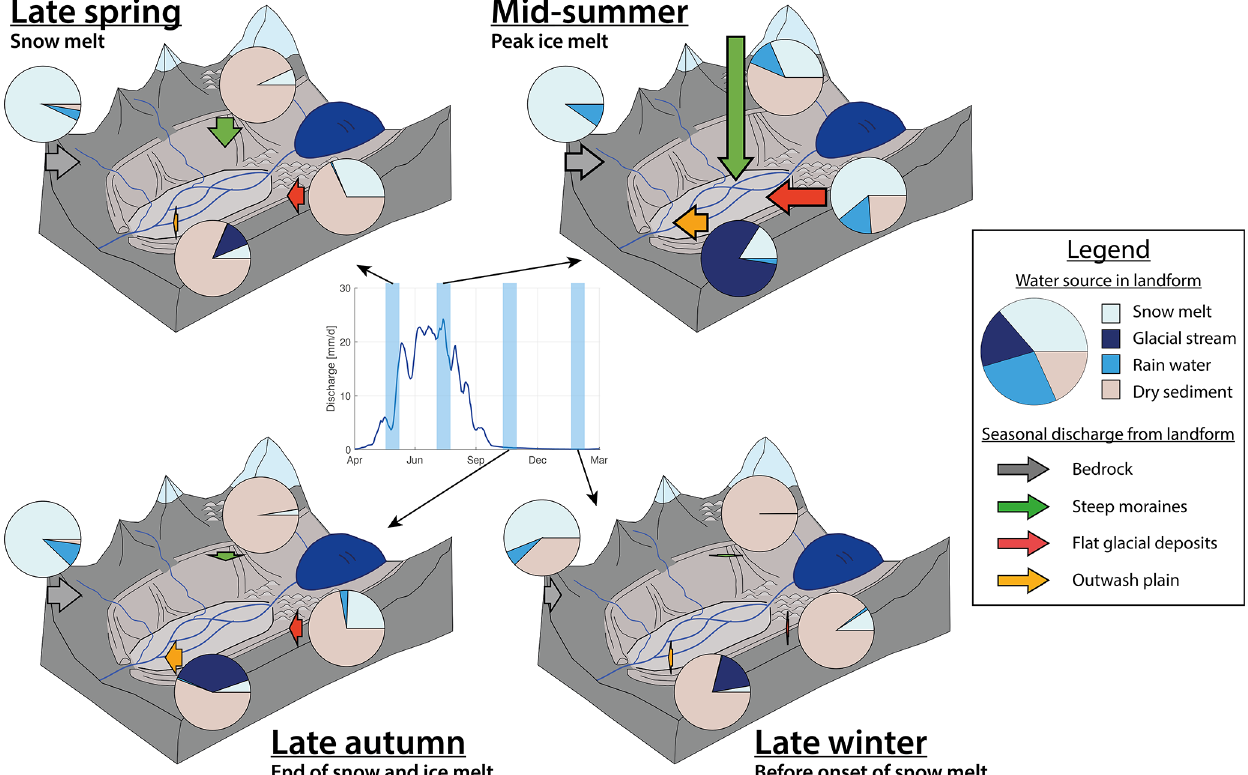
Figure 13. Perceptual model of groundwater dynamics in the Otemma catchment during four key hydrological periods. The central hydro- graph represents the mean daily catchment-scale river discharge for the year 2015. The pie charts represent the seasonal partitioning of the three water sources (rainwater, snowmelt, glacial stream) calculated based on recharge and outflow (Sect. 3.5) for the three main superficial landforms as well as a bedrock aquifer. The source “Glacial stream” represents the mixed discharge leaving the glacier outlet and is an undefined mix of ice melt and snowmelt as well as of any liquid rain transiting through the glacier. The share of dry sediments represents the percentage of aquifer storage drained compared to the calculated maximum storage (Sect. 4.4), which is 40mm for bedrock (missing storage), 23mm for the steep lateral moraines, 19mm for flatter glacial deposits, and 11mm for the outwash plain. The length of the arrows represents the relative magnitude of the baseflow discharge estimated in Fig. 12 for each